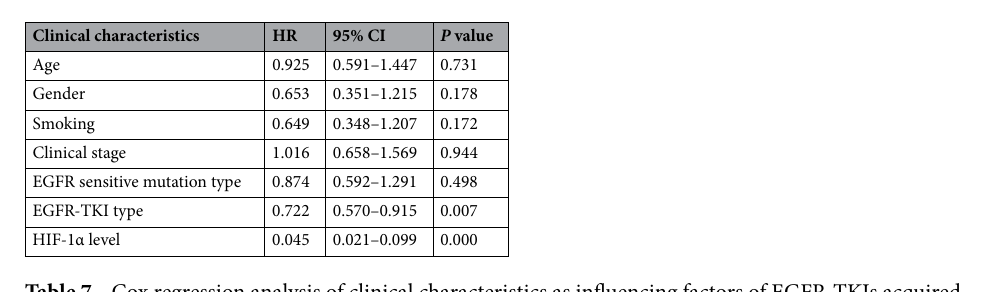
Table 7. Cox regression analysis of clinical characteristics as influencing factors of EGFR-TKIs acquired resistance occurring for 103 cases receiving EGFR-TKIs treatment. HR hazard ratio, CI confidence interval.